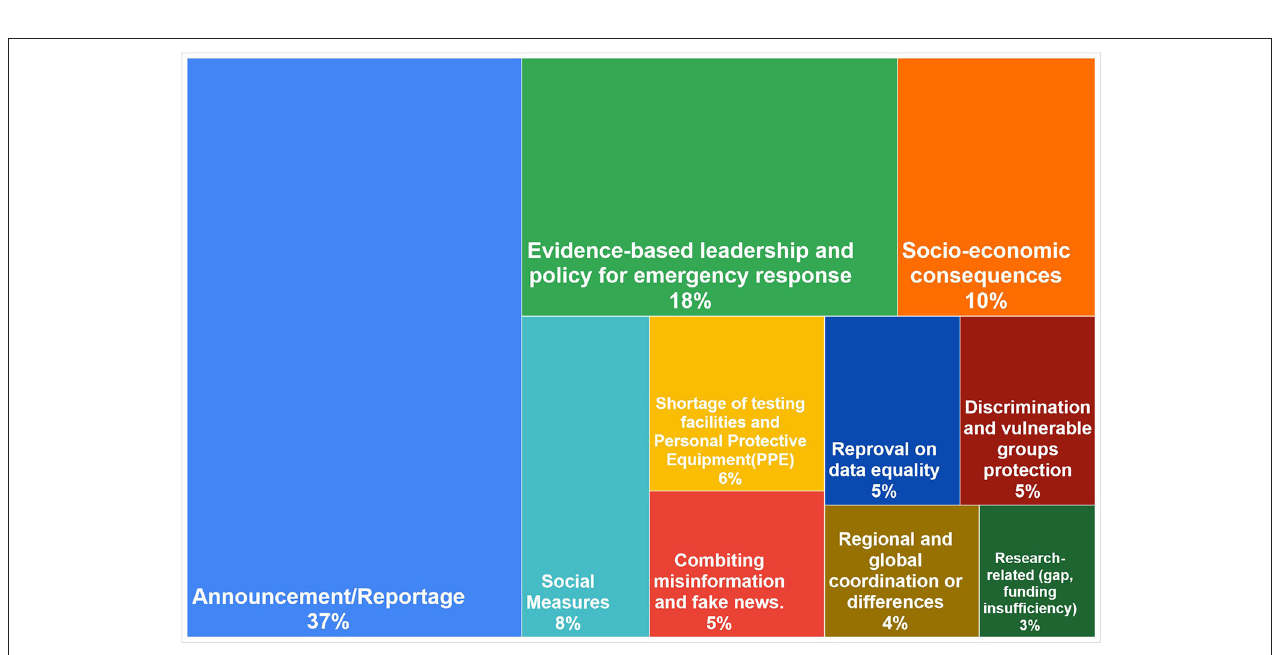
FIGURE 5 | Distribution of the clusters in the 10 themes (the area represents the theme; the percentage represents the proportion of all clusters).